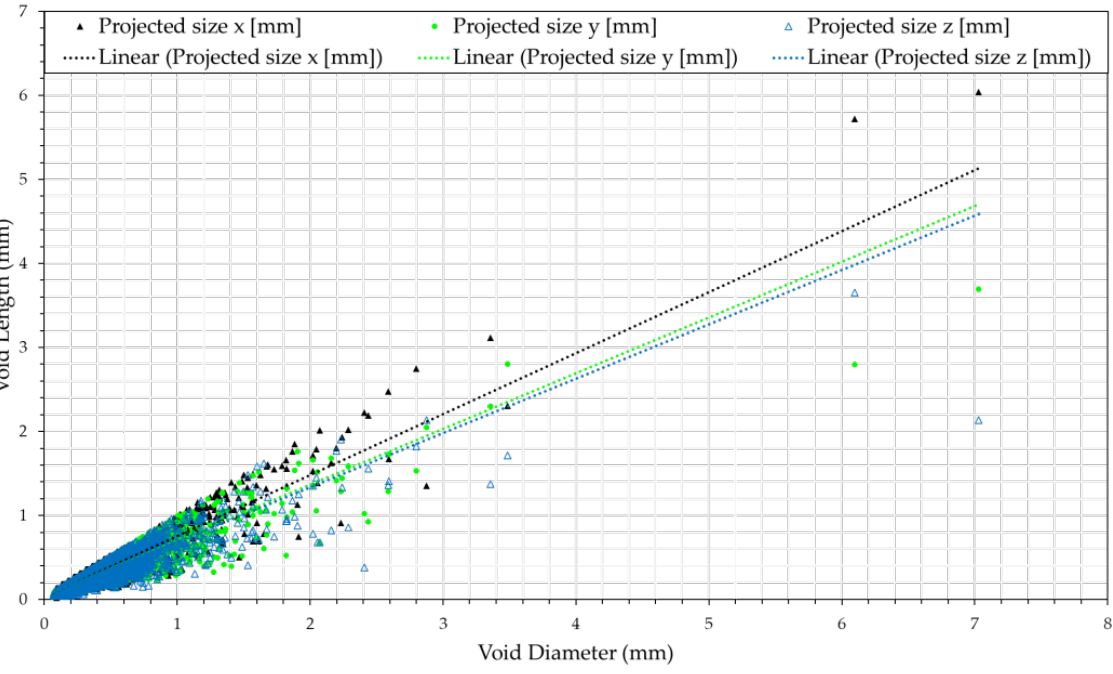
Figure 9. CAST-CM void topology from μ -CT scanning. The coefficients of determination (R 2 ) for x, y and z linear regression are 0.91, 0.92 and 0.87, respectively.